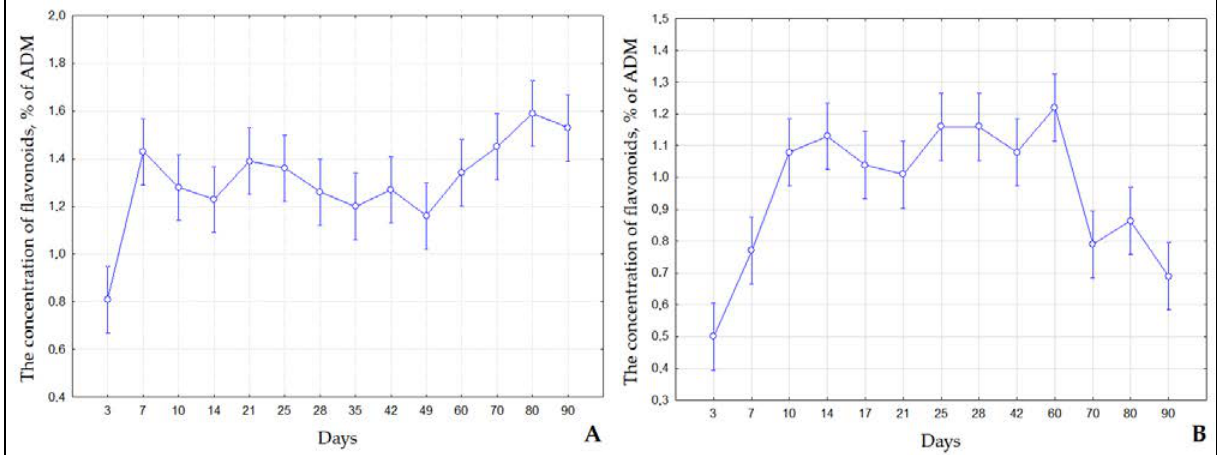
Figure 3. The concentration of flavonoids in microshoots of S. betulifolia ssp. aemiliana cultured in ( A ) agar-solidified ( B ) and liquid media. The patterns of accumulation of phenol carboxylic acids during the cultivation of S.